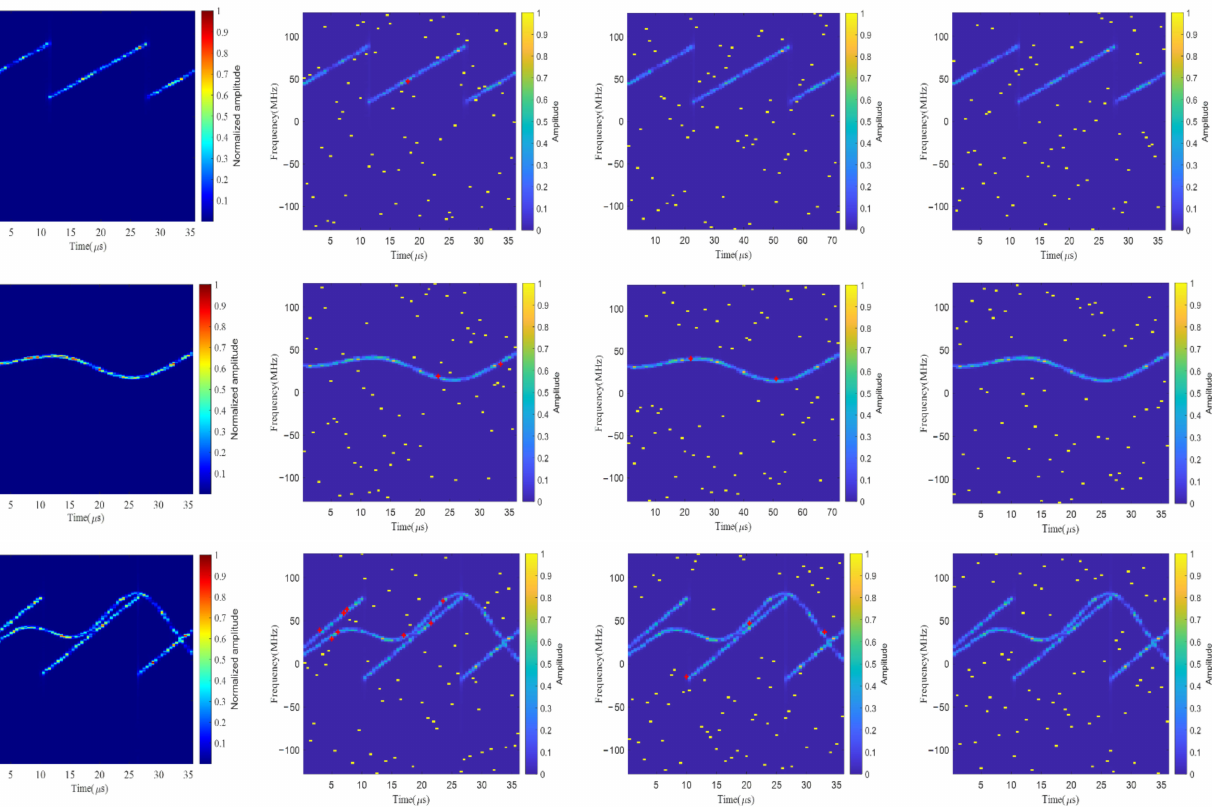
Figure 9. ( a ) The 3D position of the target and ( b ) the ground truth of target imaging. Given the ISRs of CM-WBI and SM-WBI as 70 dB and other parameters randomly selected from Table 1, Figure 10 shows the TF images of different WBIs in the duration of measurement and different transmitting RSSF waveforms. The first column of Figure 10 is the TF images of CM-WBI only, SM-WBI only, and the mixed WBI. The last three columns of Figure 10 are the TF images of the transmitting waveforms designed via random selection, the SWD method, and the proposed WBI prediction method. The red crosses in the TF images mark the frequencies that are overlapped with the WBI in the TF domain. In other words, the red crosses represent the interfered sub-pulses in the received signal.